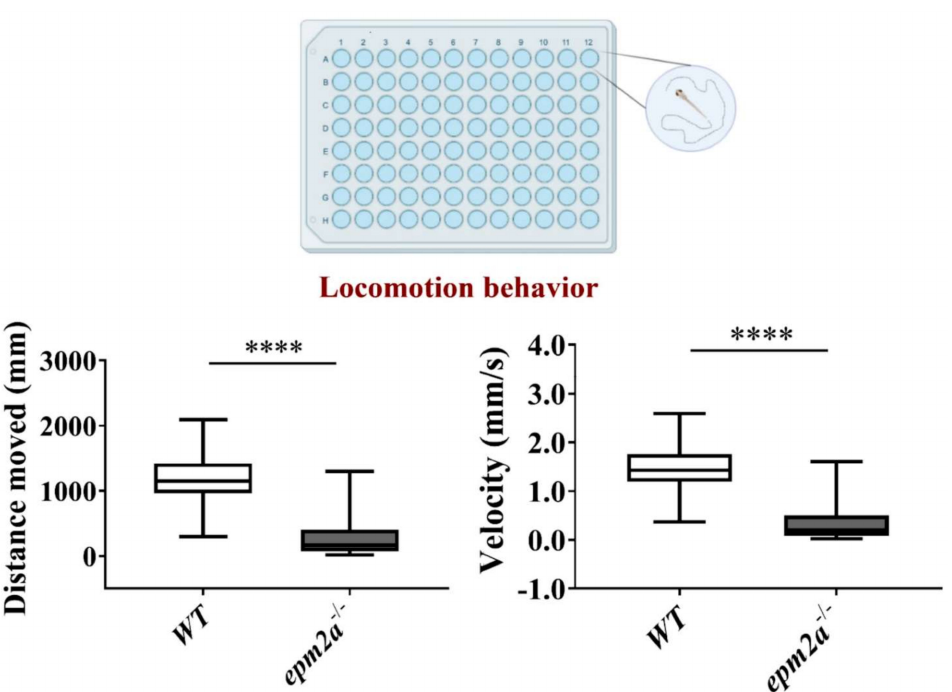
Figure 5. Locomotor activity in epm2a − / − zebrafish larvae. Automated analysis of spontaneous motor activity recording for 30 min revealed reductions in distance traveled and velocity in epm2a − / − larvae compared with control siblings at 120 hpf ( epm2a − / − n = 190; controls n = 152, in 3 independent experiments). Statistical analysis (**** p ≤ 0.0001) was performed using the Mann-Whitney